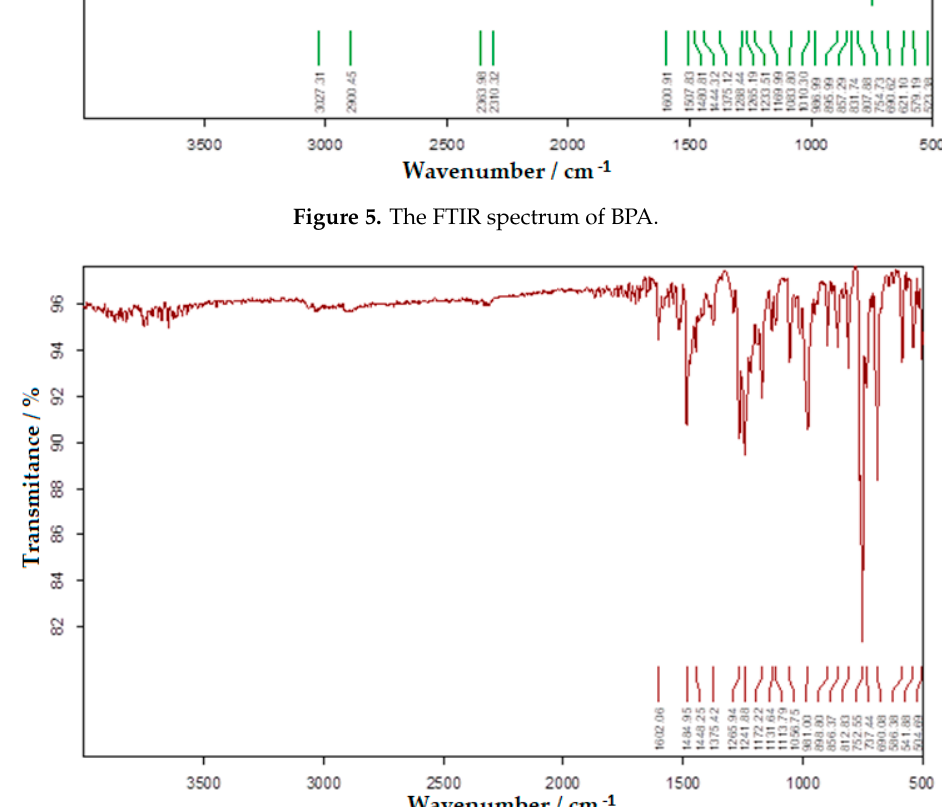
Figure 6. The FTIR spectrum of BTA.